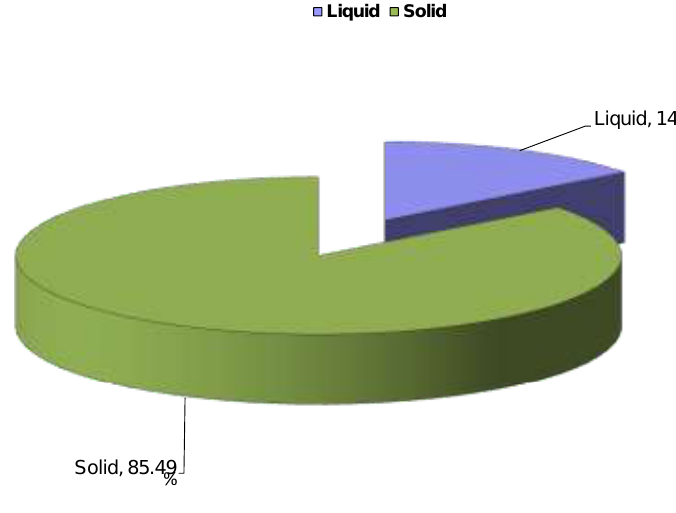
Figure 4: waste classification based on physical properties